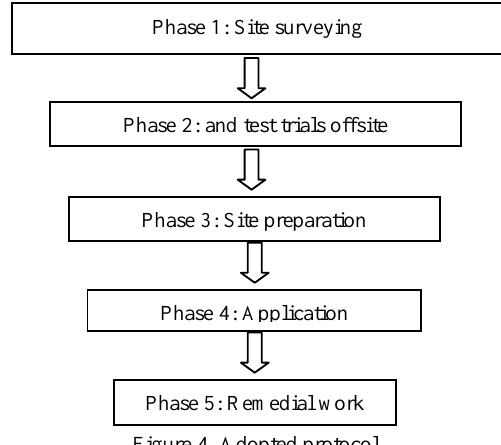
Figure 4. Adopted protocol